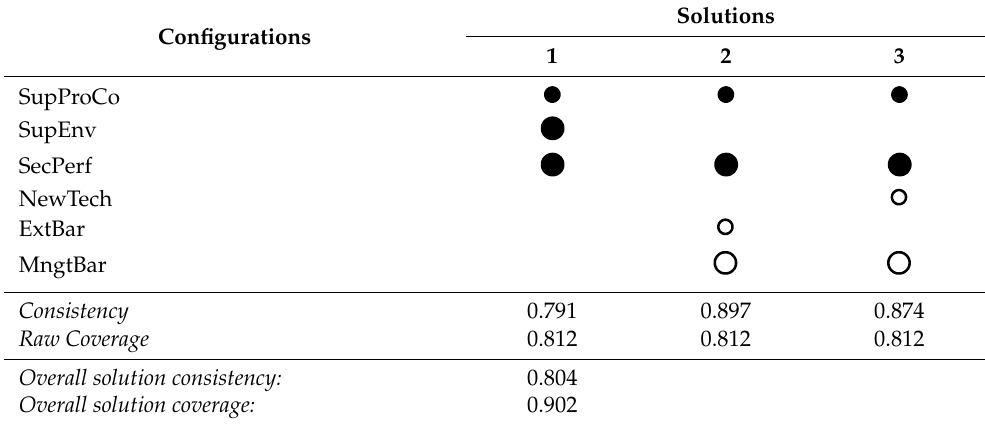
Table 8. fsQCA results: key and peripheral conditions for achieving effects of digitalization. Configurations